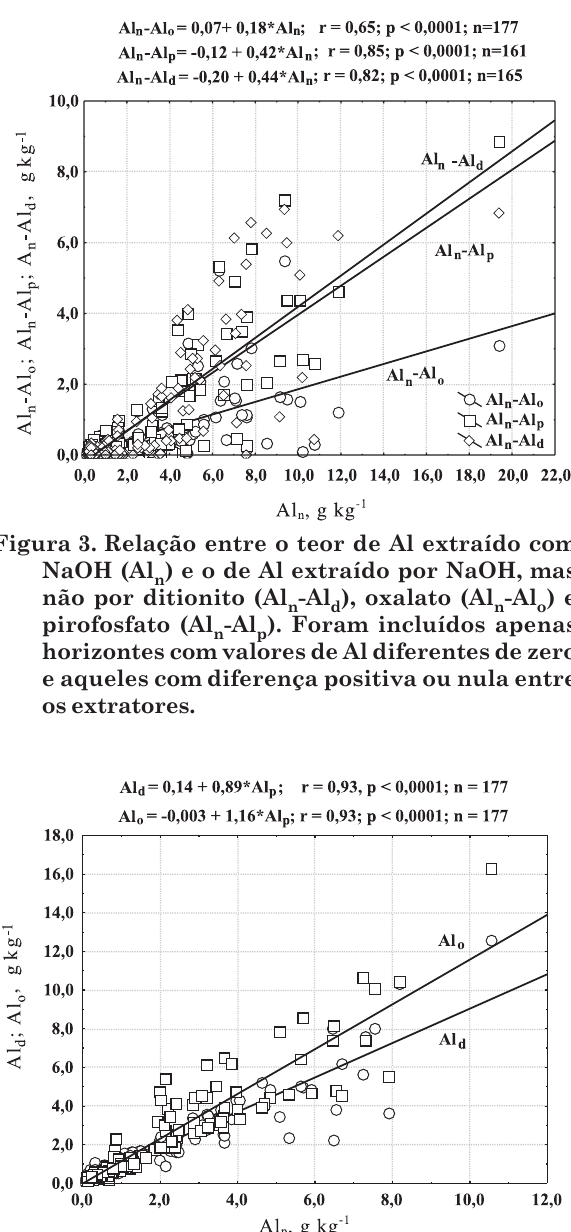
Figura 4. Relação entre os extratores DC, pirofosfato e oxalato para todos os horizontes dos perfis